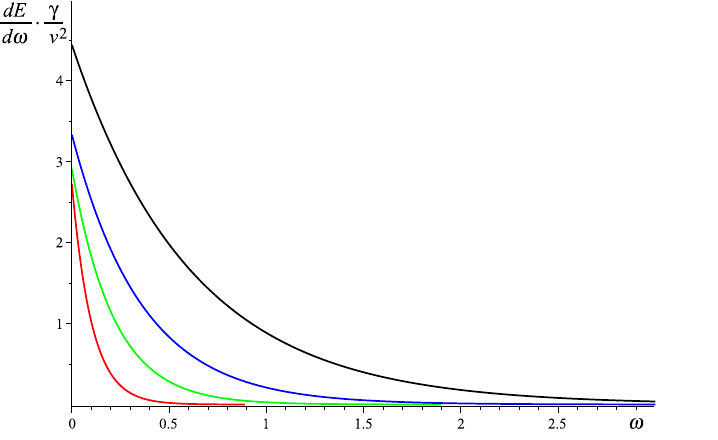
Figure 2. Plots of the ϑ -distribution of the scalar bremsstrahlung, normalized by the overall factor 2 7 ( π / γ v ) 3 , in units G = µ = b = f = 1: v = 0.1 (red), v = 0.3 (green), v = 0.5 (blue), v = 0.7 (black), v = 0.9 (magenta).